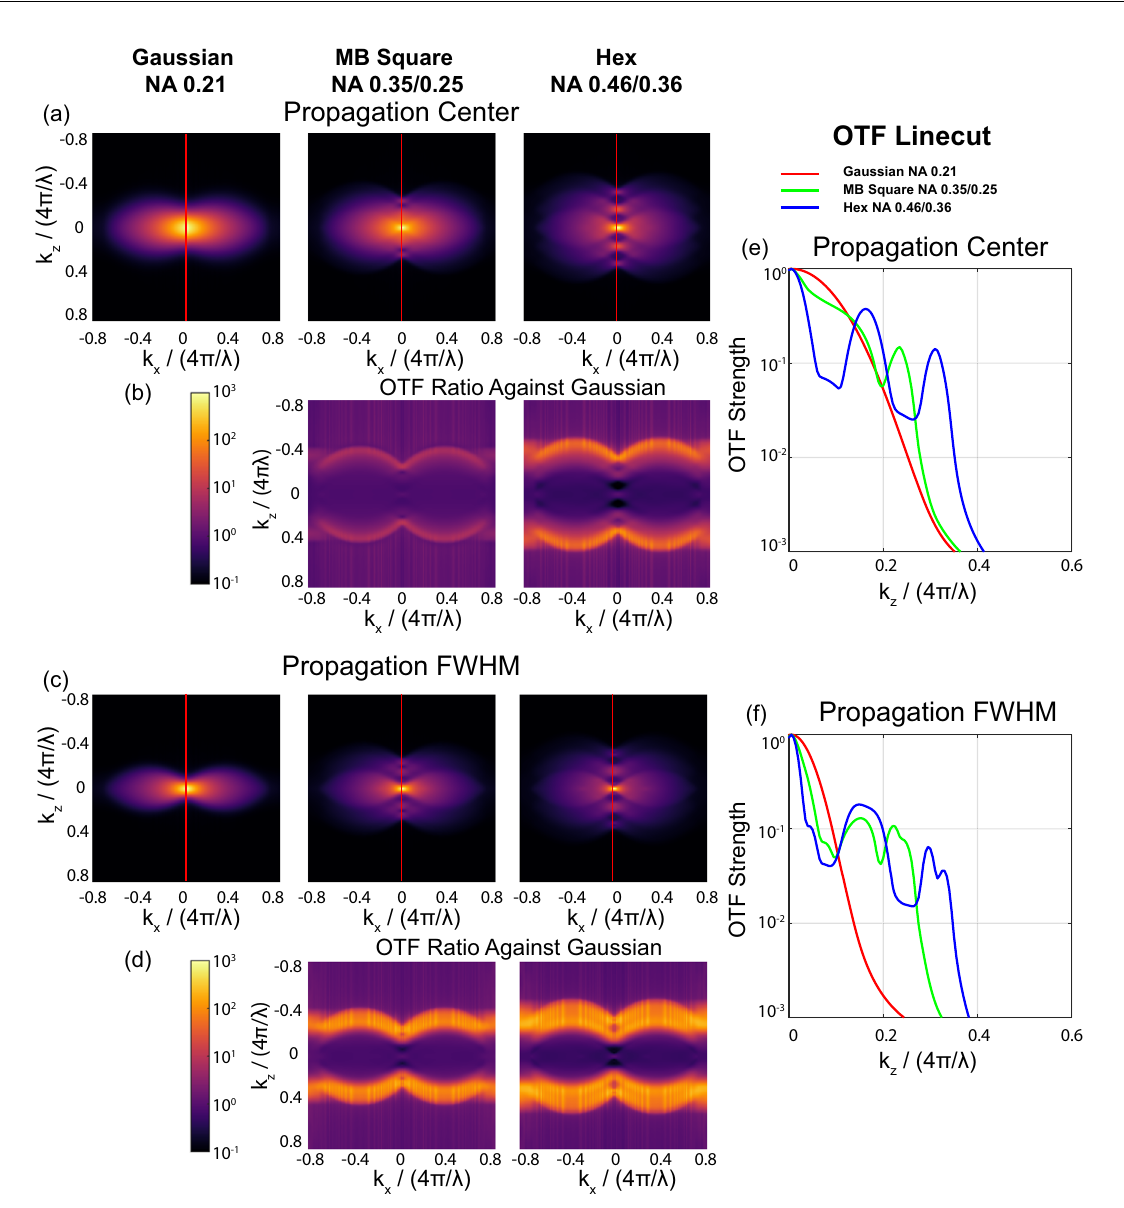
Fig. 1 | Real space characterizations of 20 µ m-long Gaussian, MB-square and hexagonal lattice light sheets. a Schematic drawing of detection and excitation objectives showing the sample and pupil plane coordinate reference frames. b Simulated yz propagation pro fi les of the three different beams, 0 indicates the beam focus and the white dashed line indicates the propagation FWHM, the posi- tion where the intensity drops to 50% of the peak at the focus. c Line cut at z =0 along the propagation direction in ( b ). d Line pro fi le along z for the excitation pattern shown in b at the beam focus ( y =0, top row) and at the full-width half maximum (FWHM) along the beam propagation ( y =24 λ , bottom row). Wide fi eld